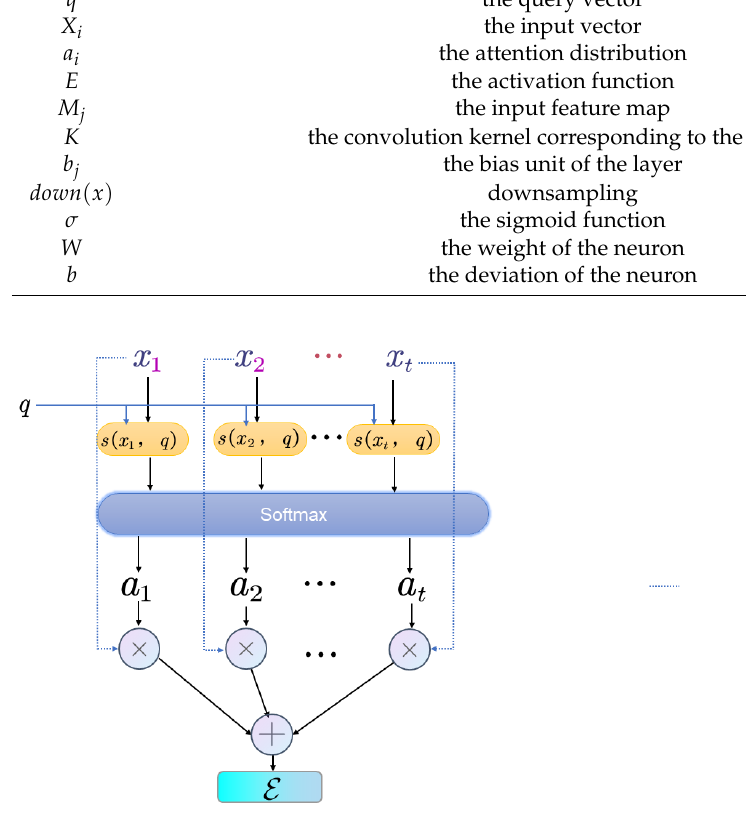
Figure 2. The operation flow chart of the attention